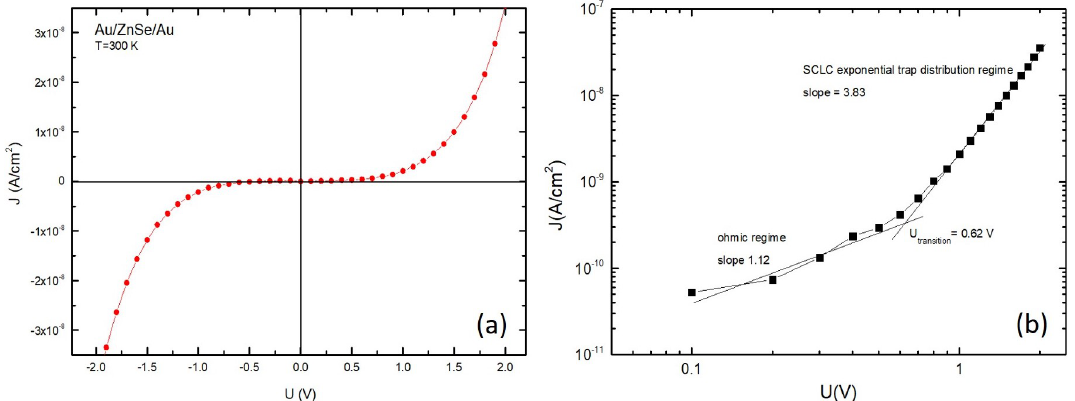
Figure 9. ( a ) Current–voltage (I-V) dark ambipolar characteristics recorded at room temperature for Au/ZnSe/Au sandwich structure, with ZnSe thin film sputtered at 100 W. ( b ) Corresponding I-V characteristics of Au/ZnSe/Au at room temperature, plotted in a double-logarithmic